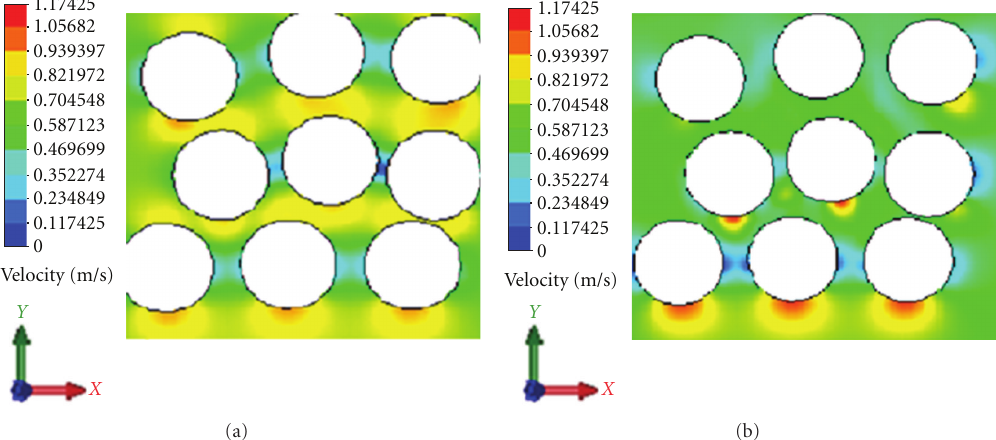
Figure 11: Velocity vectors profile in an axial cut model velocity profile expressed in